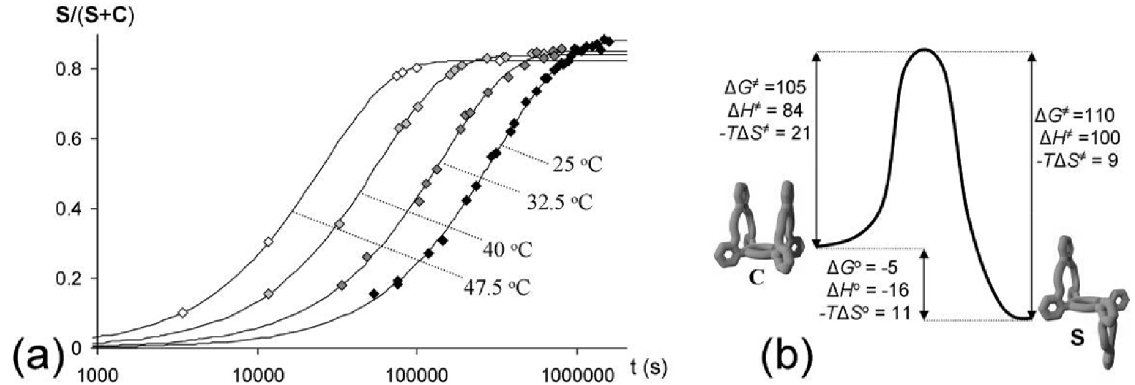
Figure 3. ( a ) Kinetics of switching from C to S at different temperatures in CDCl 1:1 ( v / v ), monitored by 1 H-NMR. ( b ) Energy diagram of the switching process with the entropic and enthalpic parameters (all in kJ/mol).